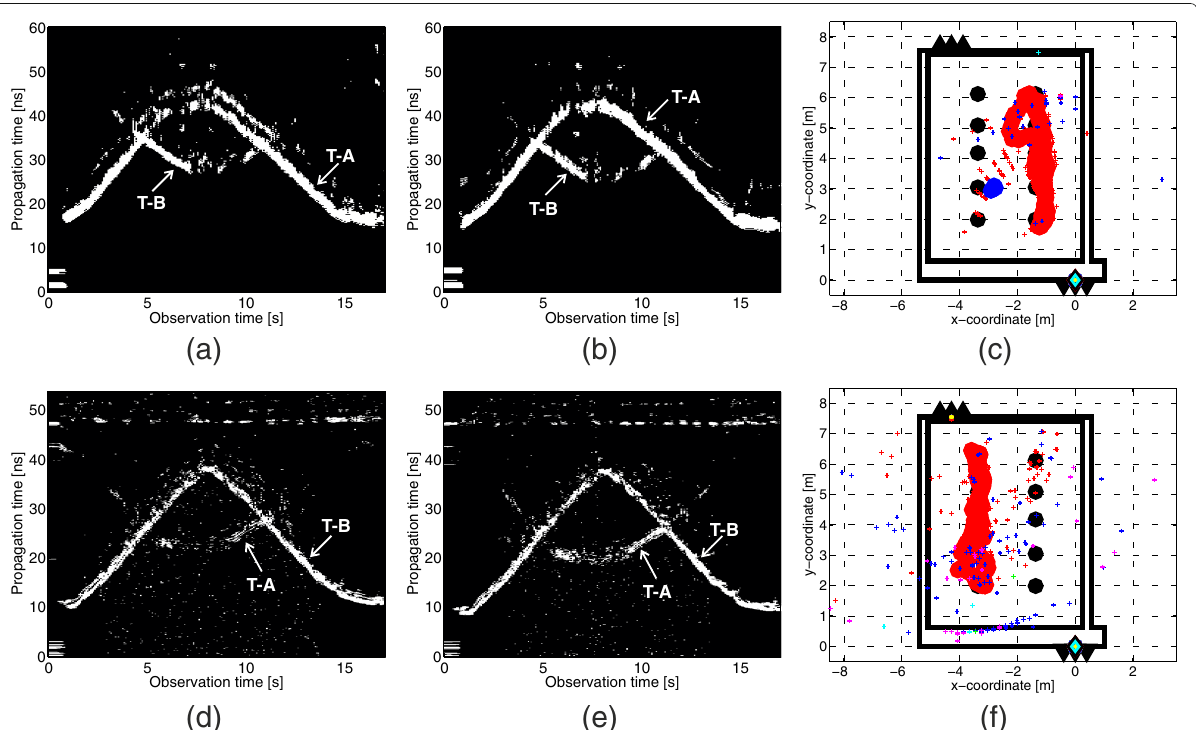
Fig. 5 Illustration of the impact of dynamic shielding (scenario 1). Detection, localization ( plussign symbols) and tracking results obtained by the sensor S1: a detector output for Rx 1,1 , b detector output for Rx 1,2 and c final target tracks. Detection, localization ( plussign symbols) and tracking results obtained by the sensor S2: d detector output for Rx 2,1 , e detector output for Rx 2,2 and f final target